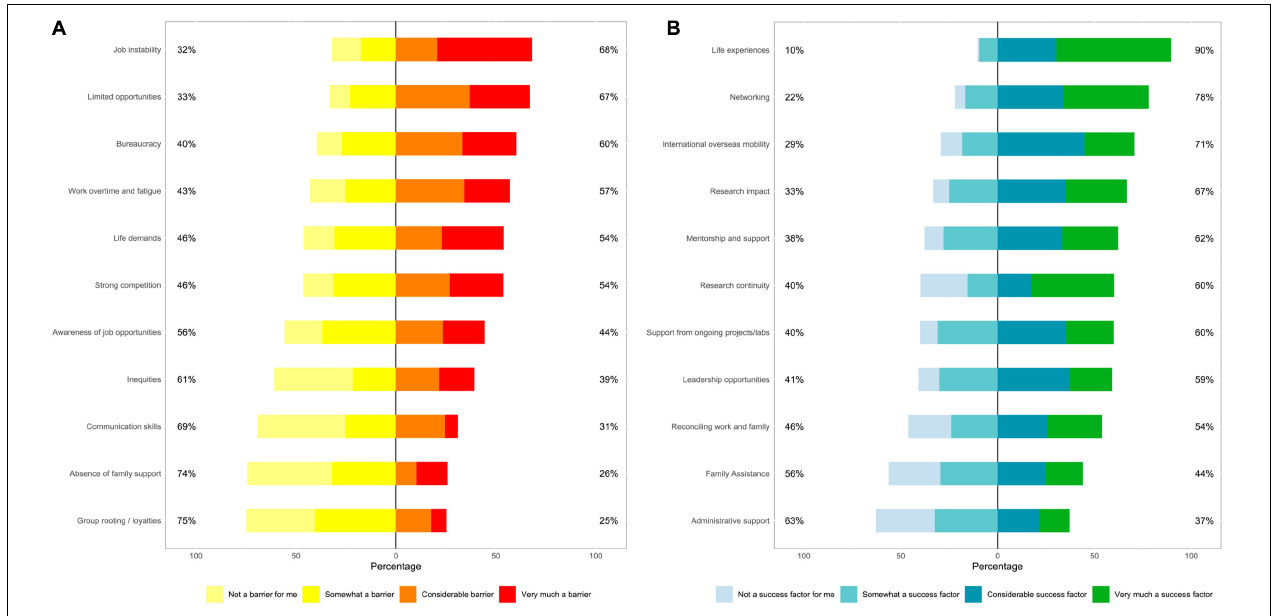
FIGURE 2 | Barriers (A) and success factors (B) ranked by